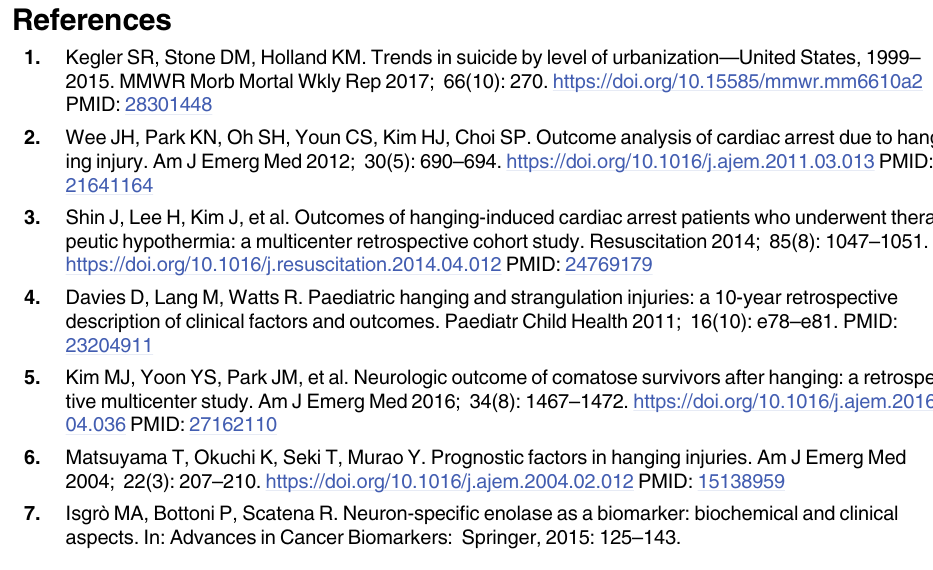
S1 Table. Comparison between the female and male group in near-hanging